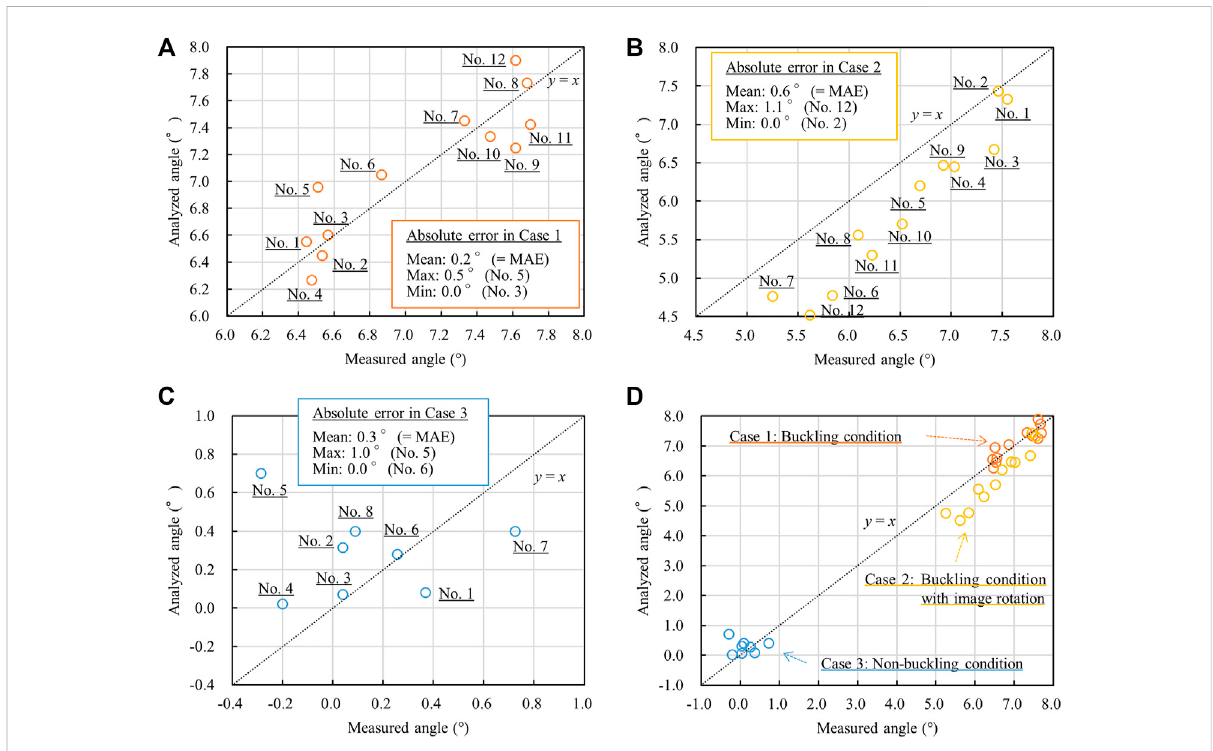
FIGURE 10 The comparison of measured and analyzed angles. (A) Case 1: Buckling condition. (B) Case 2: Buckling condition with image rotation. (C) Case 3: Non-buckling condition. (D) Results of Case 1, Case 2, and Case